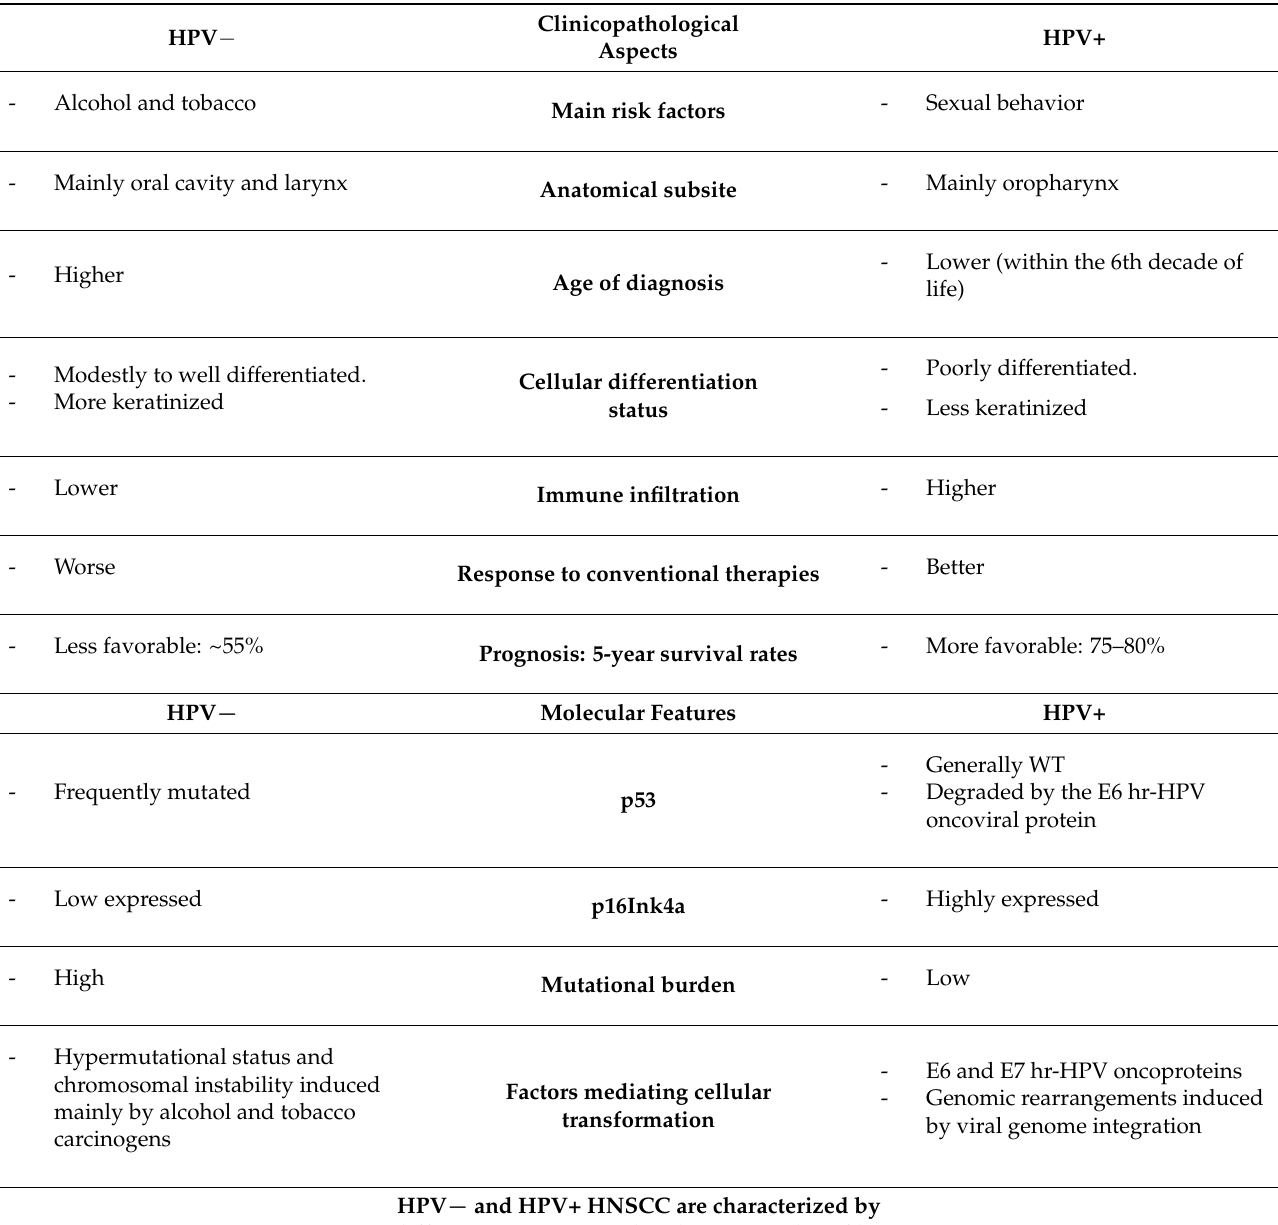
Table 1. Table summarizing the main clinicopathological and molecular differences distinguishing the HPV − and the HPV+ HNSCC